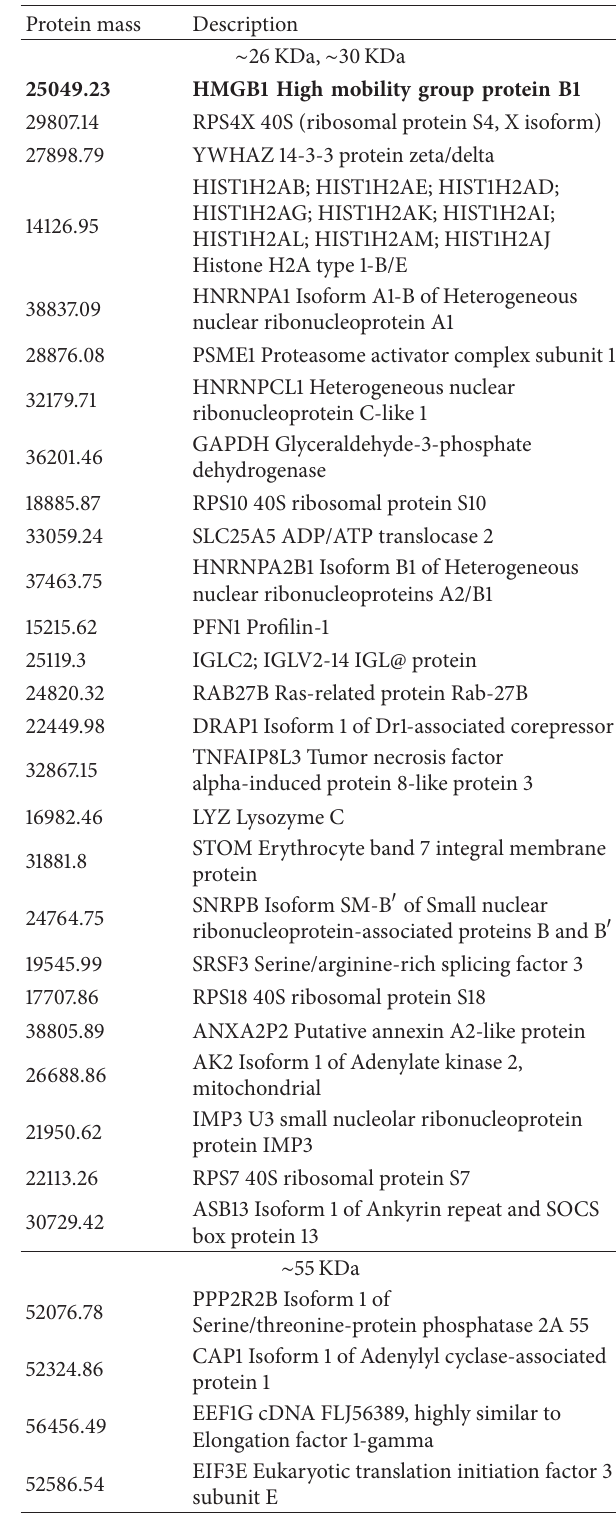
Table 2: Proteins identified by